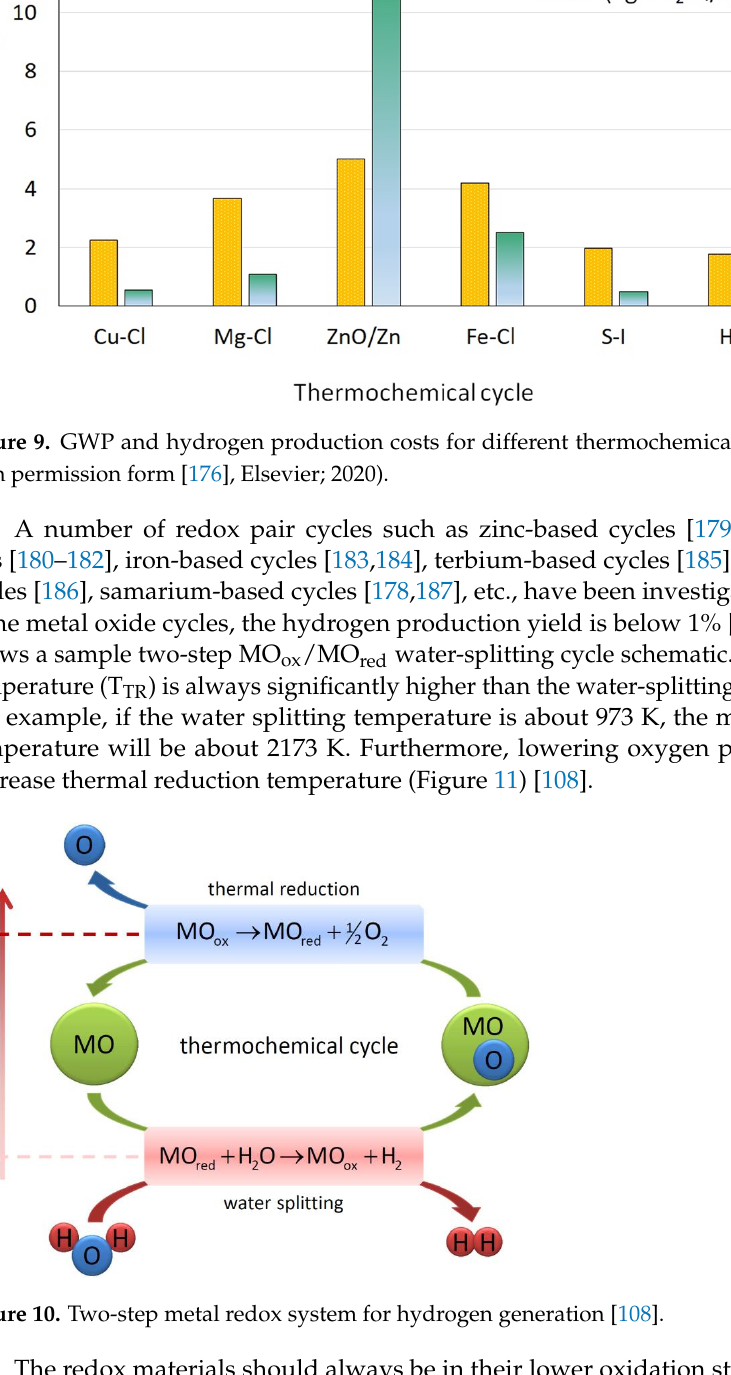
Figure 11. Thermal reduction temperature as a function of oxygen partial pressure [108]. The redox materials should always be in their lower oxidation states which exhibits less noble characteristics than hydrogen. The energetic expenses of the reverse reaction from higher to lower oxidation state (redox material regeneration) should be as low as possible. Thermodynamically, the regeneration reaction should occur at the highest tem- perature (Figure 12).